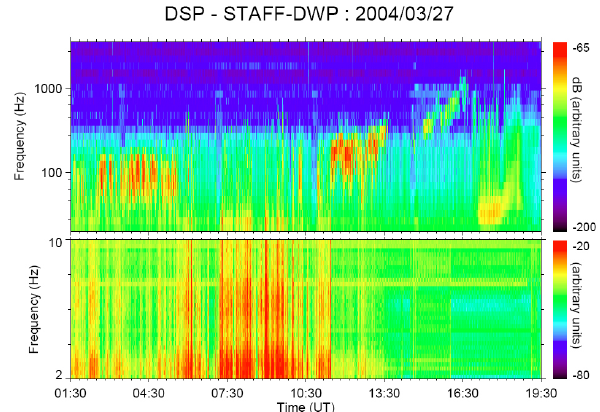
Fig. 5. Dynamic spectra of the less noisy component of the STAFF wave form data (from 2 to 10Hz) on the bottom and of the DWP spectrum analyzer (from 20Hz to 4kHz) on the top, for 27 March 2004, with a 1-min time resolution. Similar plots, for 3h and for full orbit time periods, are available on DSDS web: http://edds02.iwf.oeaw.ac.at/dsdsweb-cgi/dsdsweb